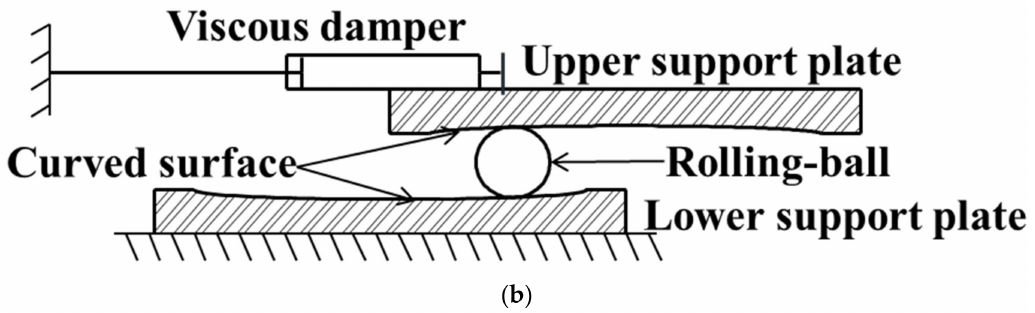
Figure 1. Two typical states of the proposed device with ( a ) as the initial state and ( b ) in motion.